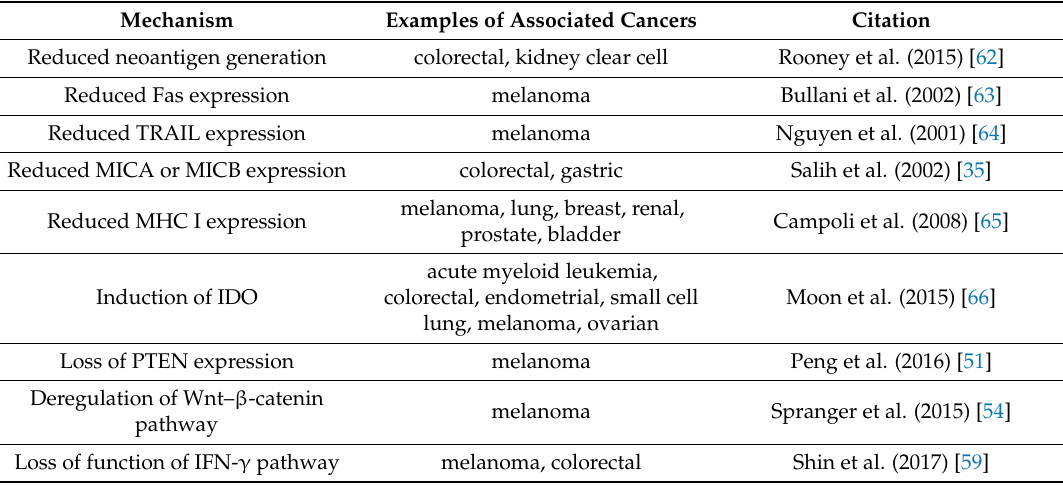
Table 1. Mechanisms of resistance to